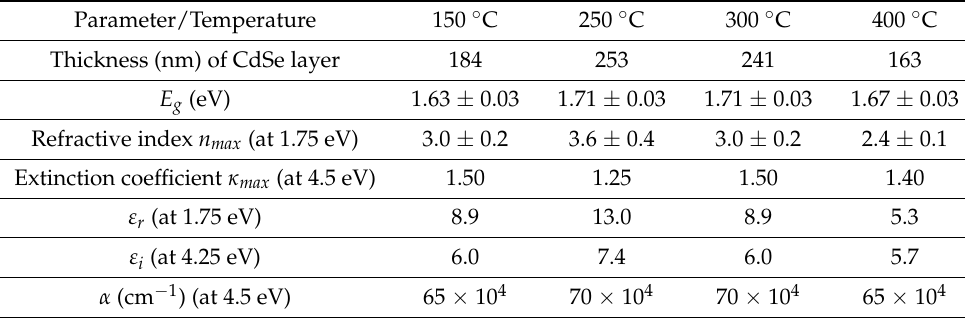
Table 2. Parameters extracted from spectroscopic ellipsometry.